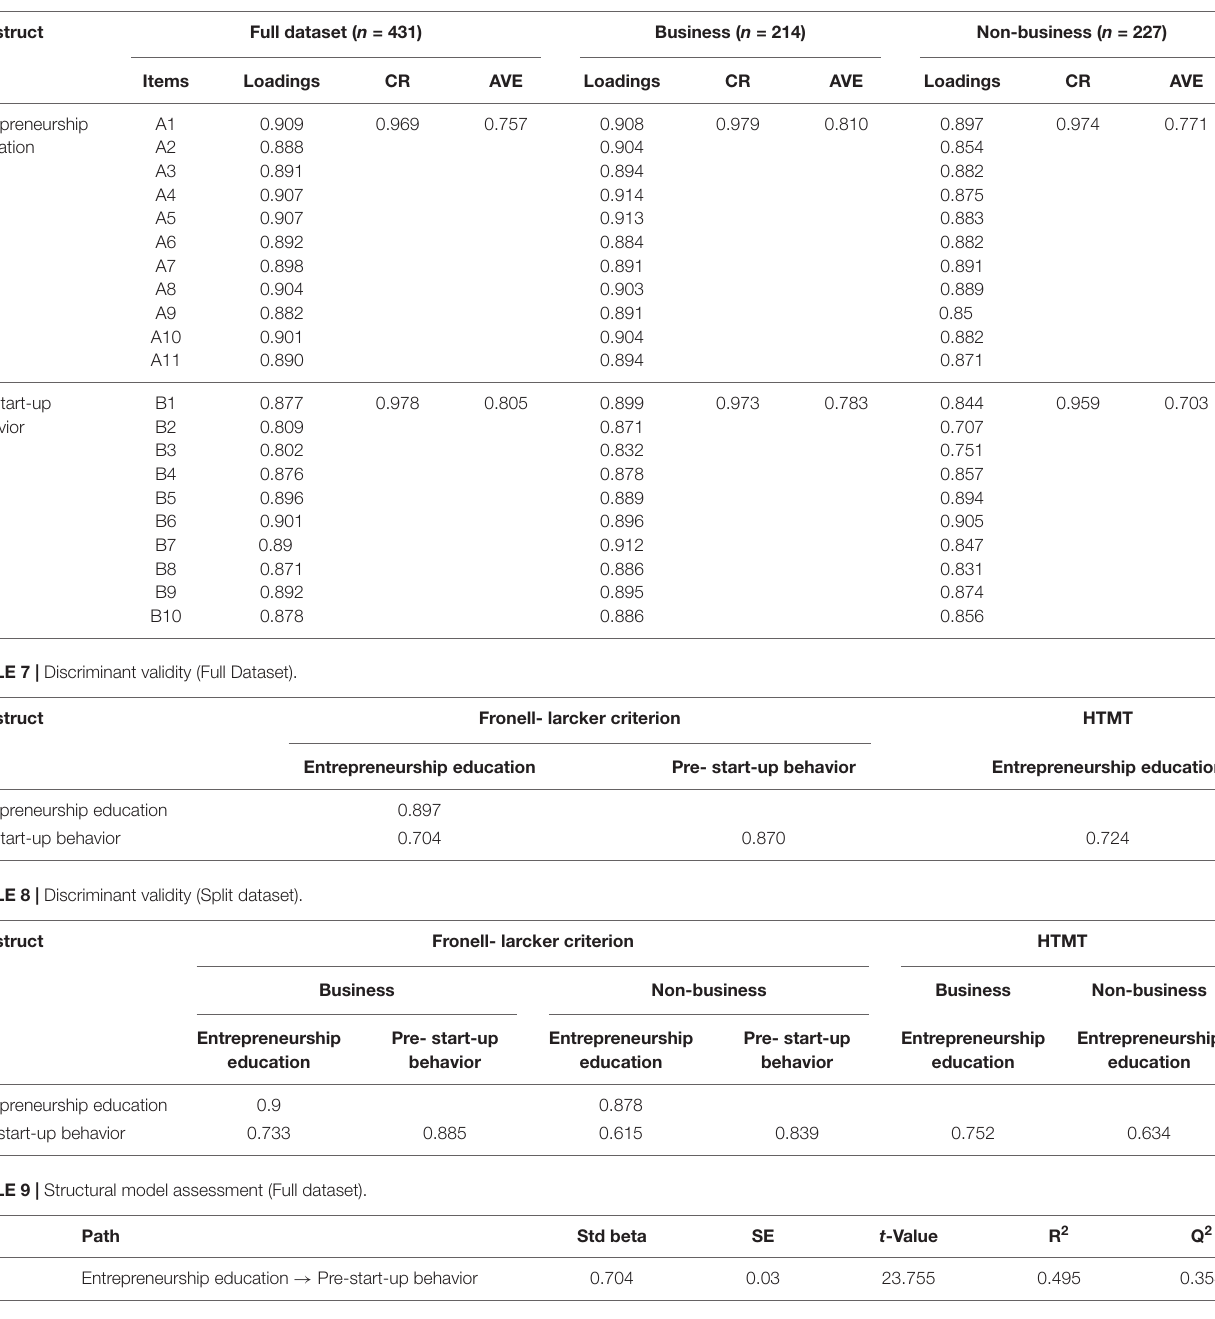
TABLE 6 | Assessment of full measurement model and samples.